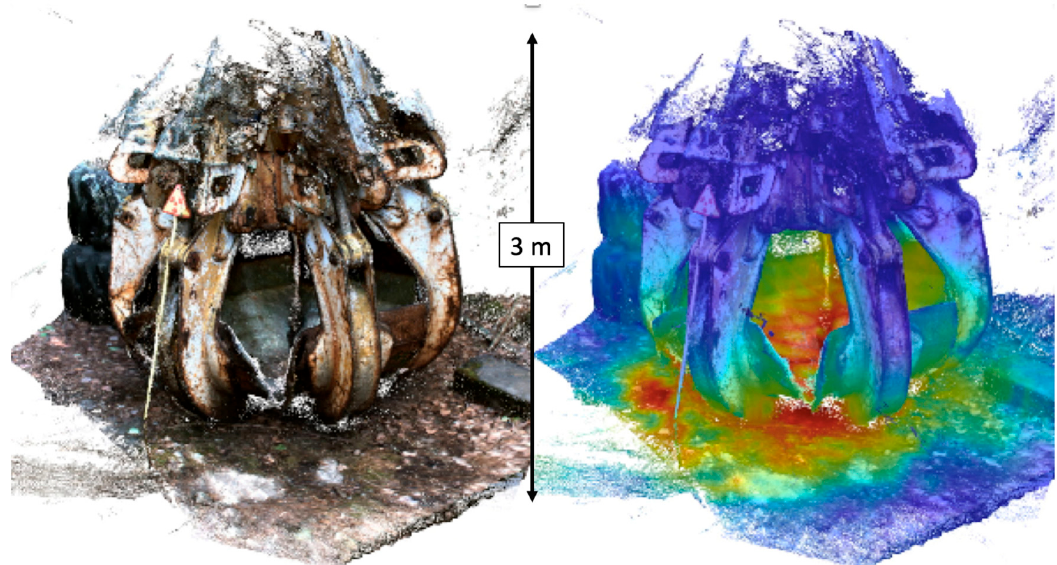
Figure 5. Model of the crane claw located close to the Chernobyl Nuclear Power Plant (ChNPP) in Ukraine. The left model was reconstructed via photogrammetry using visual camera data and served as the basis for the right model, which shows a fused model with the reconstructed gamma-ray emission data provided by a commercially available and hand-portable instrument integrated with SDF. The image was created for 662 keV associated with Cs-137. One can easily see that most of the Cs-137 radioactivity is inside and underneath the claw. Behind the claw, two stacked truck tires are clearly visible.